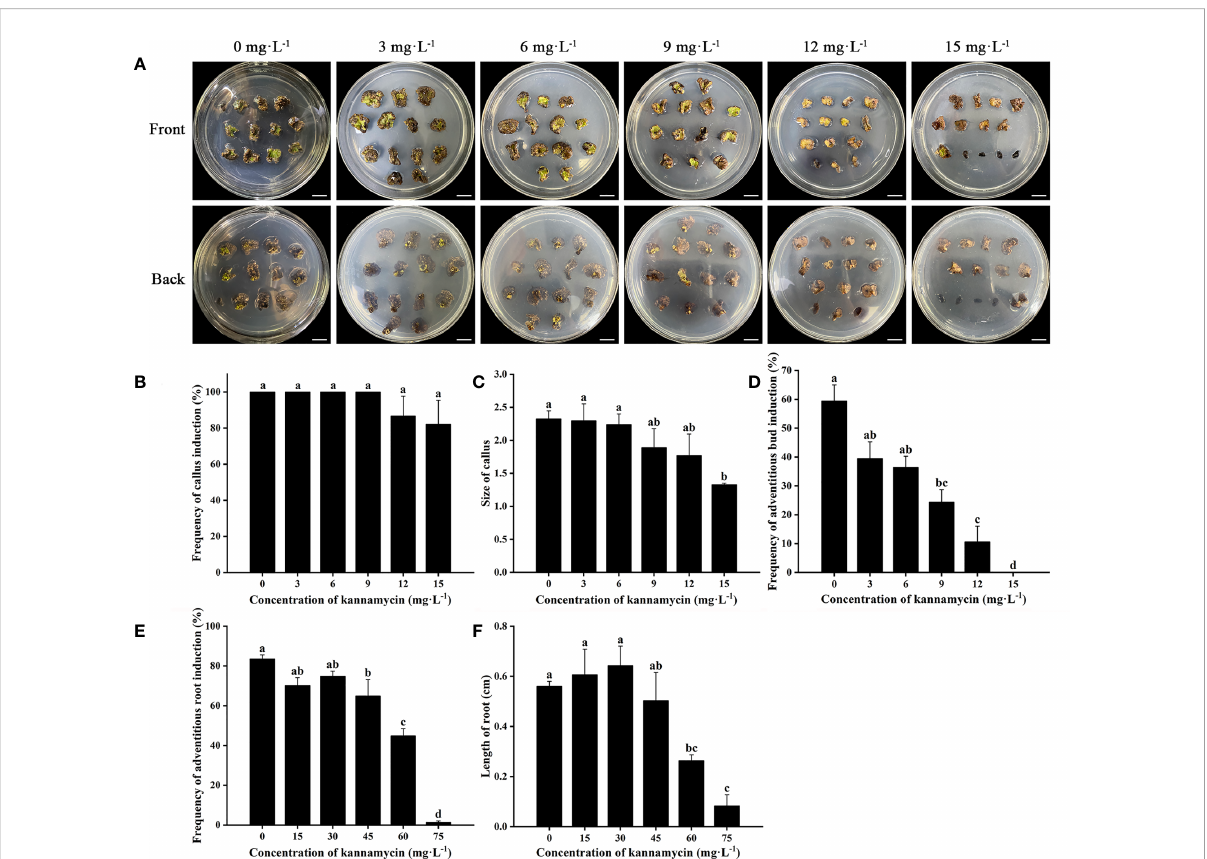
FIGURE 4 Effects of kanamycin on regeneration of E. urophylla × E. grandis DH32-29. (A) Explants are induced to regenerate adventitious buds on medium supplemented with 0, 3, 6, 9, 12, and 15 mg·L − 1 kanamycin. Effects of kanamycin on (B) the frequency of callus induction, (C) callus size, (D) the frequency of adventitious bud induction, (E) the frequency of adventitious root induction, and (F) the length of roots. Scale bar: 1 cm. Different letters indicate signi fi cant differences among treatments using Duncan ’ s multiple range test at p <